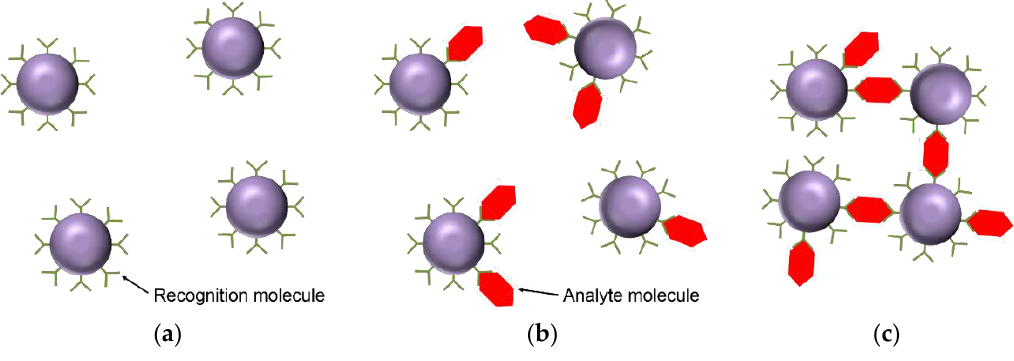
Figure 2. Possible effects upon analyte molecule binding to magnetic particle labels: ( a ) Particles with immobilized recognition molecules on the surface; ( b ) Analyte molecules (red structure) bound to the particle surfaces increase the hydrodynamic volumes of the single particles; ( c ) Particle clustering induced by analyte molecule binding.